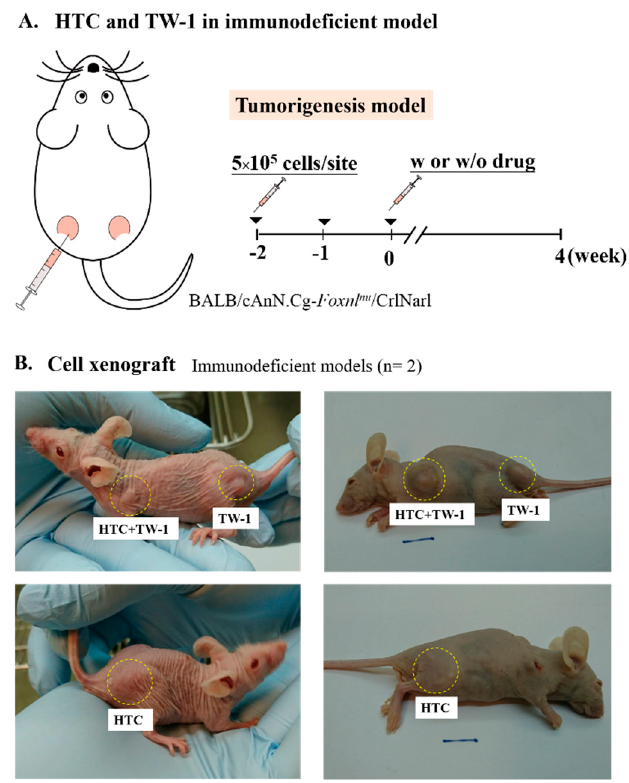
Figure 2. HTC and TW-1 transplantation in null mice. ( A ) The schematic design of the mouse model for HTC and TW-1 xenografts. Male immunodeficient BALB/cAnN.Cg-Foxnlnu/CrlNarl athymic nude mice were injected with HTC, TW-1 or HTC + TW-1 cells, and treated with or without sorafenib. ( B ) The appearances of xenografts in the transplanted mice.